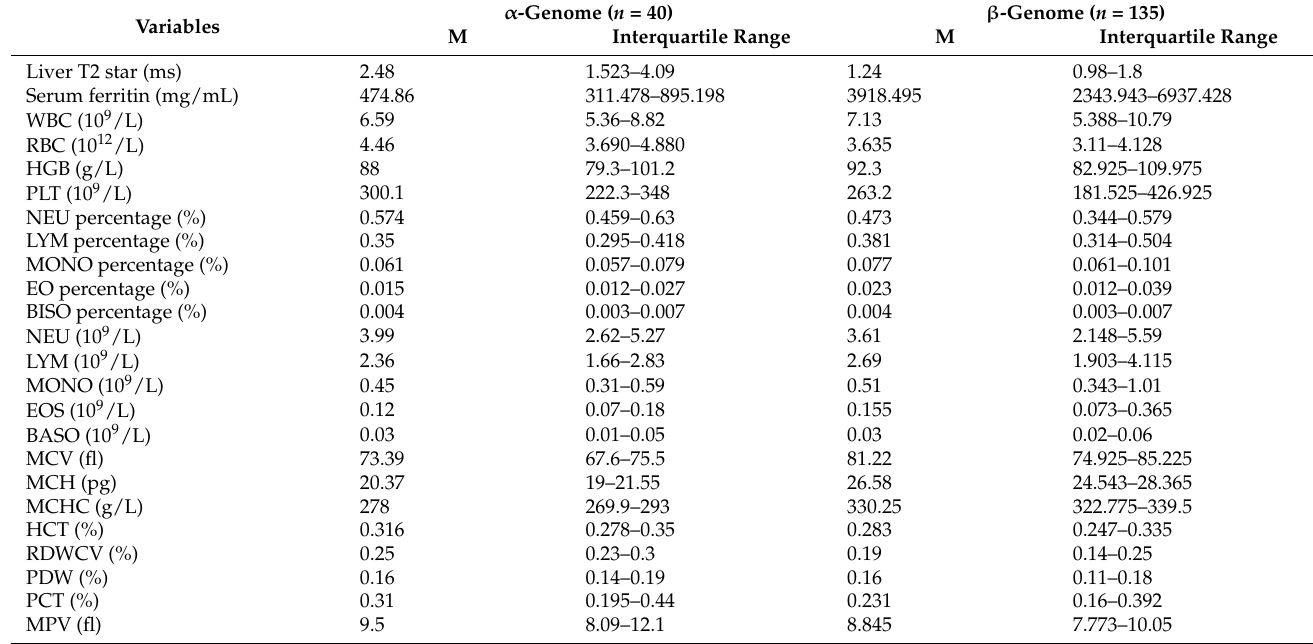
Table 1. Clinical baseline measurement data of α -genome and β -genome patients.